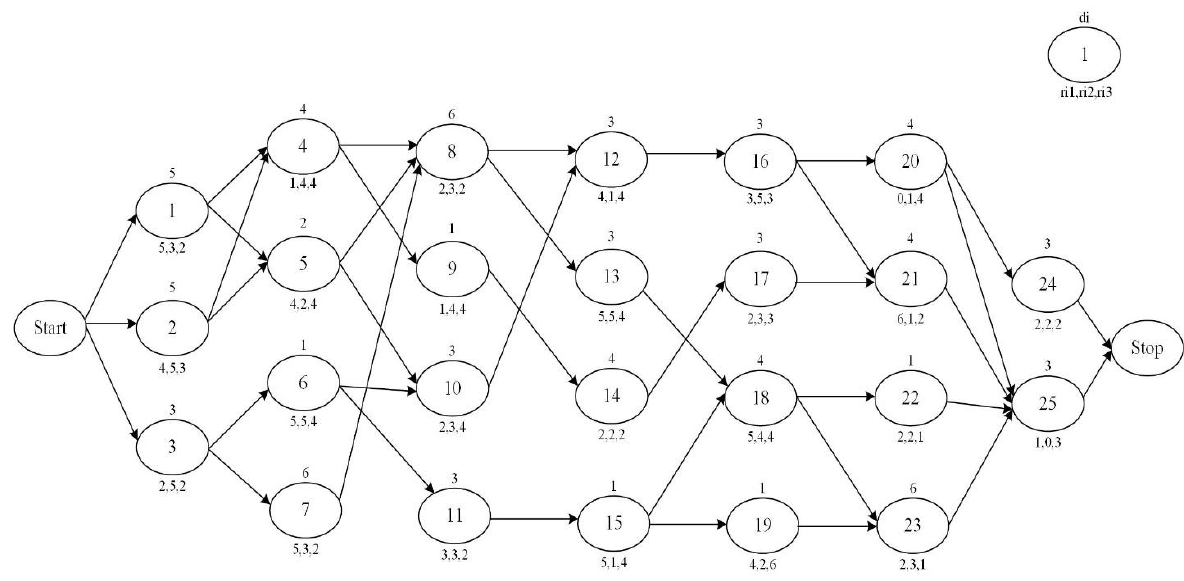
Figure 12. A typical RCPSP example [57].